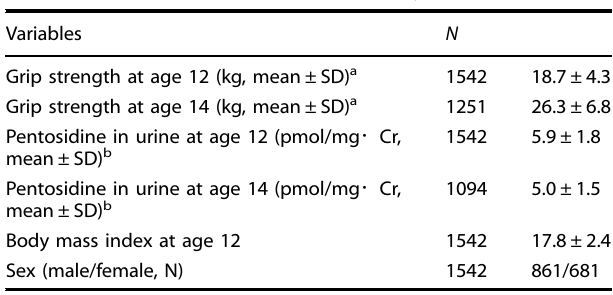
Table 1. Characteristics of participants in Study